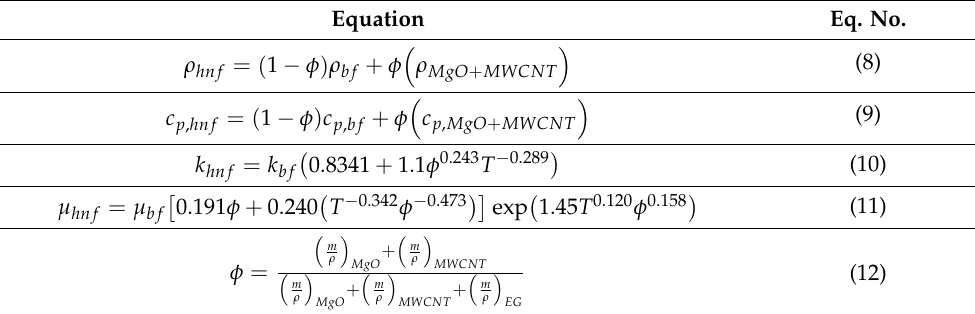
Table 5. Implemented thermophysical properties of hybrid nanofluid in the model [54,55].